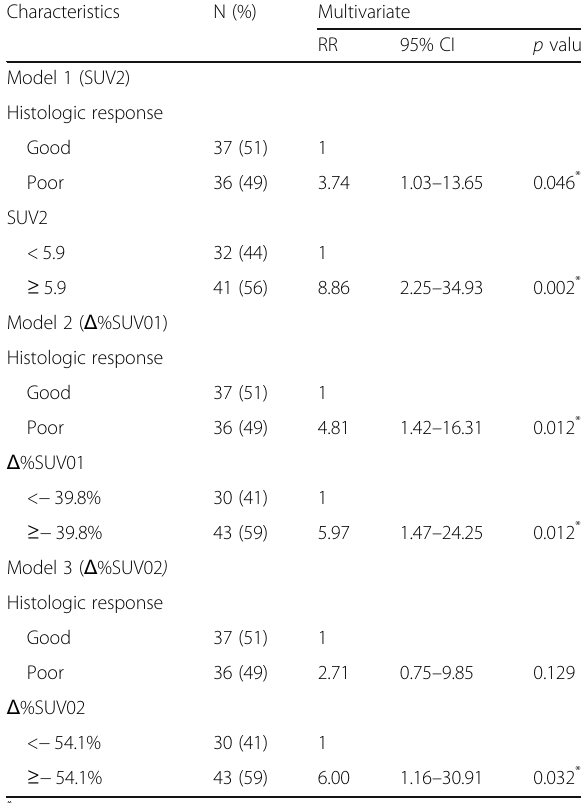
Table 4 Multivariate Cox proportional hazards models